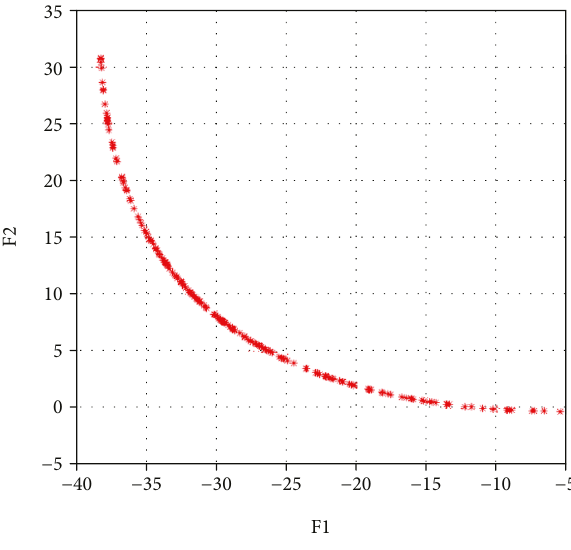
Figure 6: The Pareto optimal front of test 2.